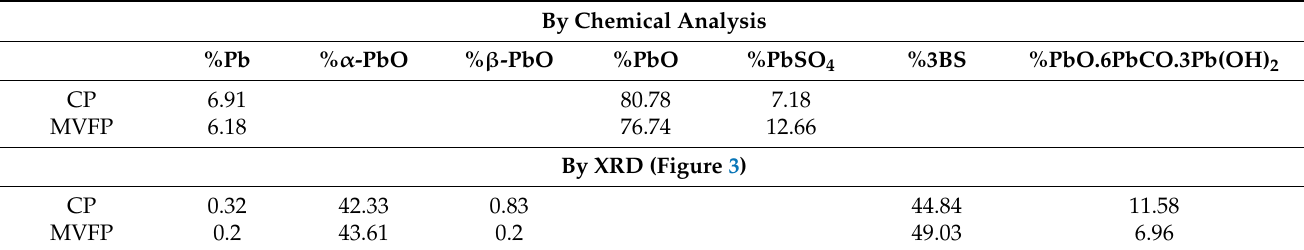
Table 6. Comparison of the chemical analysis by titration and XRD of the negative pastes after curing. By Chemical